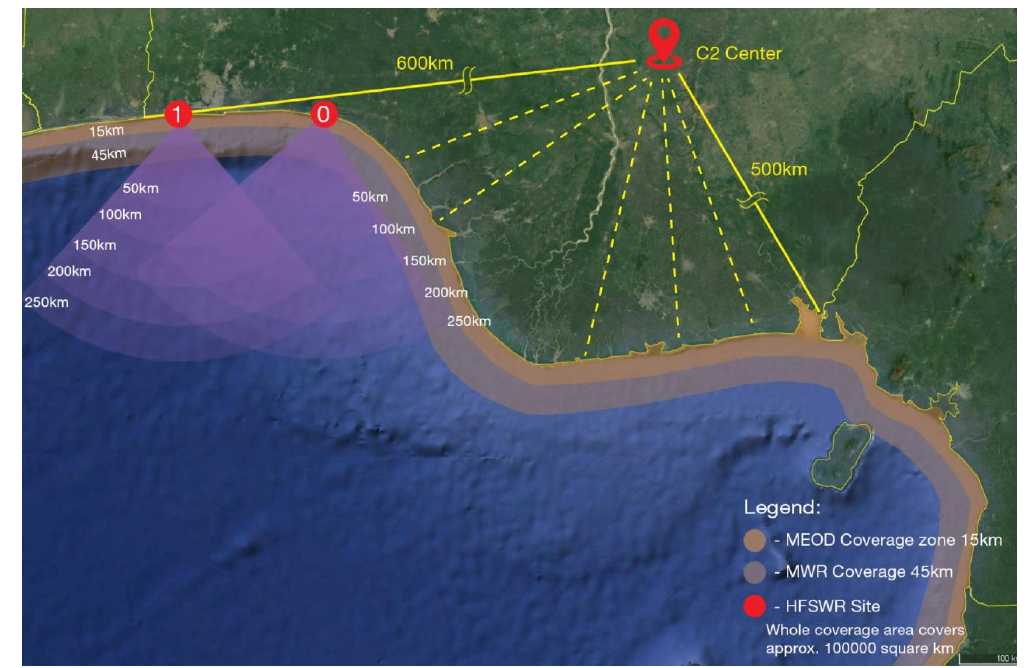
Figure 1. Deployed sensor network coverage area.